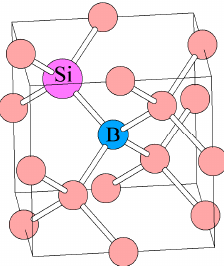
Figure 5. Proposed model for the Si-B center.